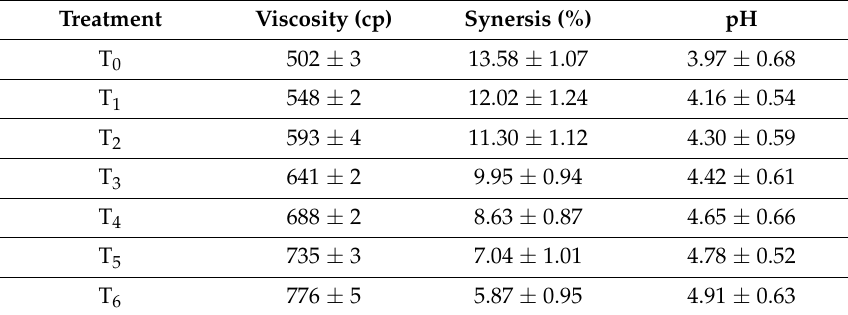
Table 5. Functional attributes of flaxseed-derived-PSG-supplemented